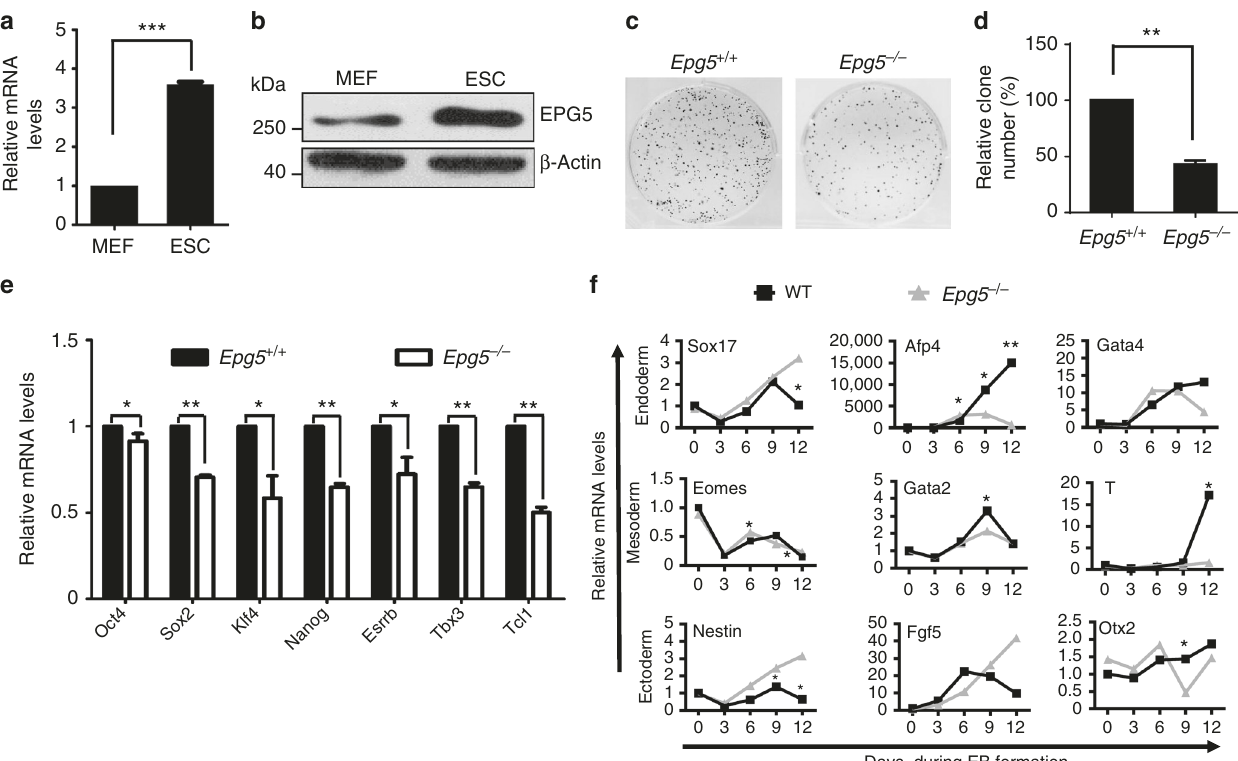
Fig. 1 EPG5 maintains ESC self-renewal and pluripotency. a The mRNA expression of Epg5 in ESCs and MEFs. Error bars indicate the standard deviation (SD) ( n = 3). Three independent biological replicates. *** P < 0.001 by unpaired two-tailed Student ’ s t test. b Western blot analysis of whole-cell extracts from MEFs and ESCs. β -Actin served as a loading control. Images are representative of three independent experiments. c , d Colony-formation assay of Epg5 + / + and Epg5 − / − ESCs. Colonies formed by ESCs were stained with alkaline phosphatase (AP). Error bars indicate the SD ( n = 5). Five independent biological replicates. ** P < 0.01 by unpaired two-tailed Student ’ s t test. e ESC pluripotency is impaired by Epg5 depletion. The relative mRNA expression of pluripotency genes in Epg5 + / + and Epg5 − / − ESCs was detected by quantitative PCR. Error bars indicate the SD ( n = 3). Three independent biological replicates. ** P < 0.01, * P < 0.05 by unpaired two-tailed Student ’ s t test. f Absence of EPG5 impairs ESC lineage speci fi cation. The relative mRNA expression levels of genes representative of the ectoderm, mesoderm, and endoderm were detected during embryonic body (EB) differentiation by quantitative PCR on the indicated days. Data shown are representative of three independent experiments. Error bars indicate the SD ( n = 4). Four independent biological replicates. ** P < 0.01, * P < 0.05 by two-way ANOVA with Bonferroni ’ s correction (WT compared with Epg5 − / −